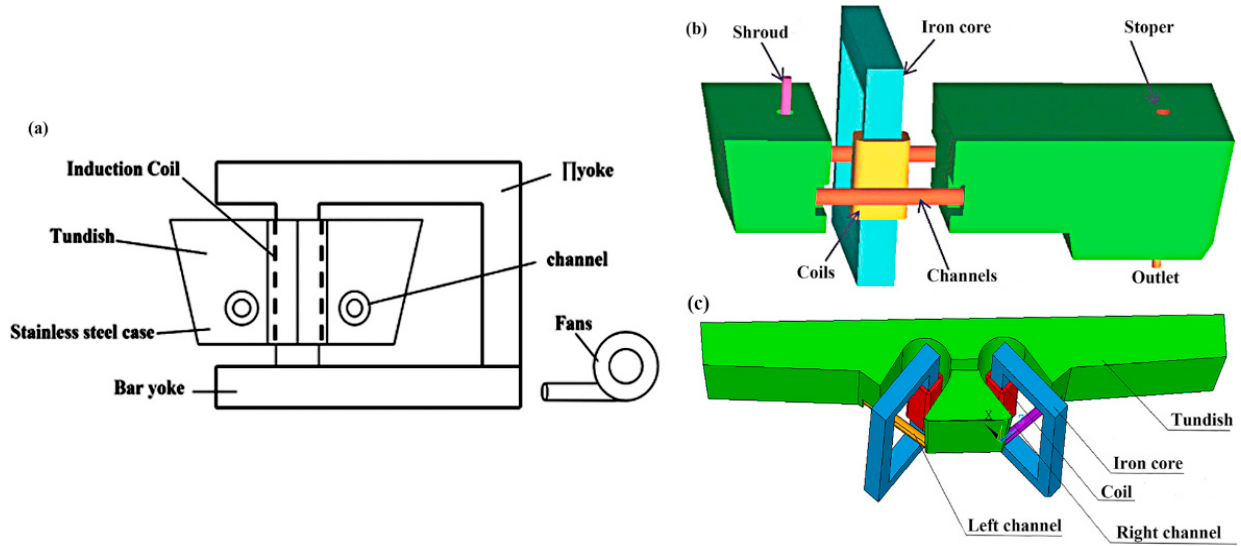
Figure 2. ( a ) Schematic of the tundish induction heating device [23] . ( b ) Tundish with a single in- duction heating device [26] . ( c ) Tundish with a single induction heating device [27] .